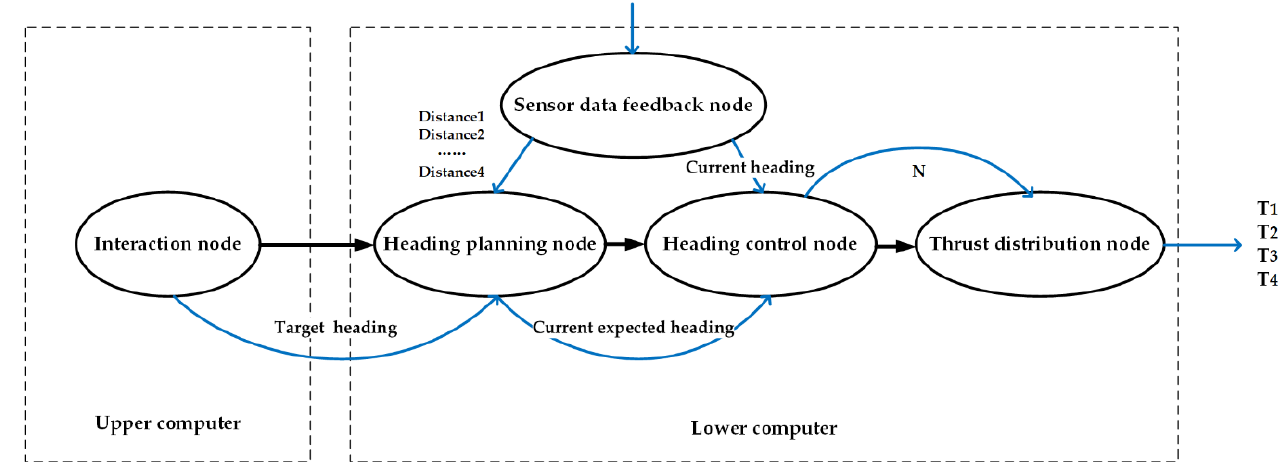
Figure 7. Schematic diagram of control system framework.